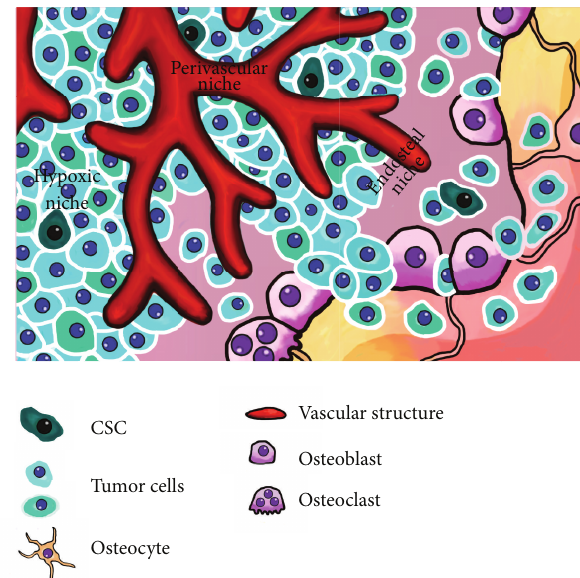
Figure 2: OS-CSC niches. The figure represents possible niches for CSCsinOS.SuggestedlocationsforCSCsaretheperivascularniche, the endosteal niche, and areas of poor vascularization (hypoxic